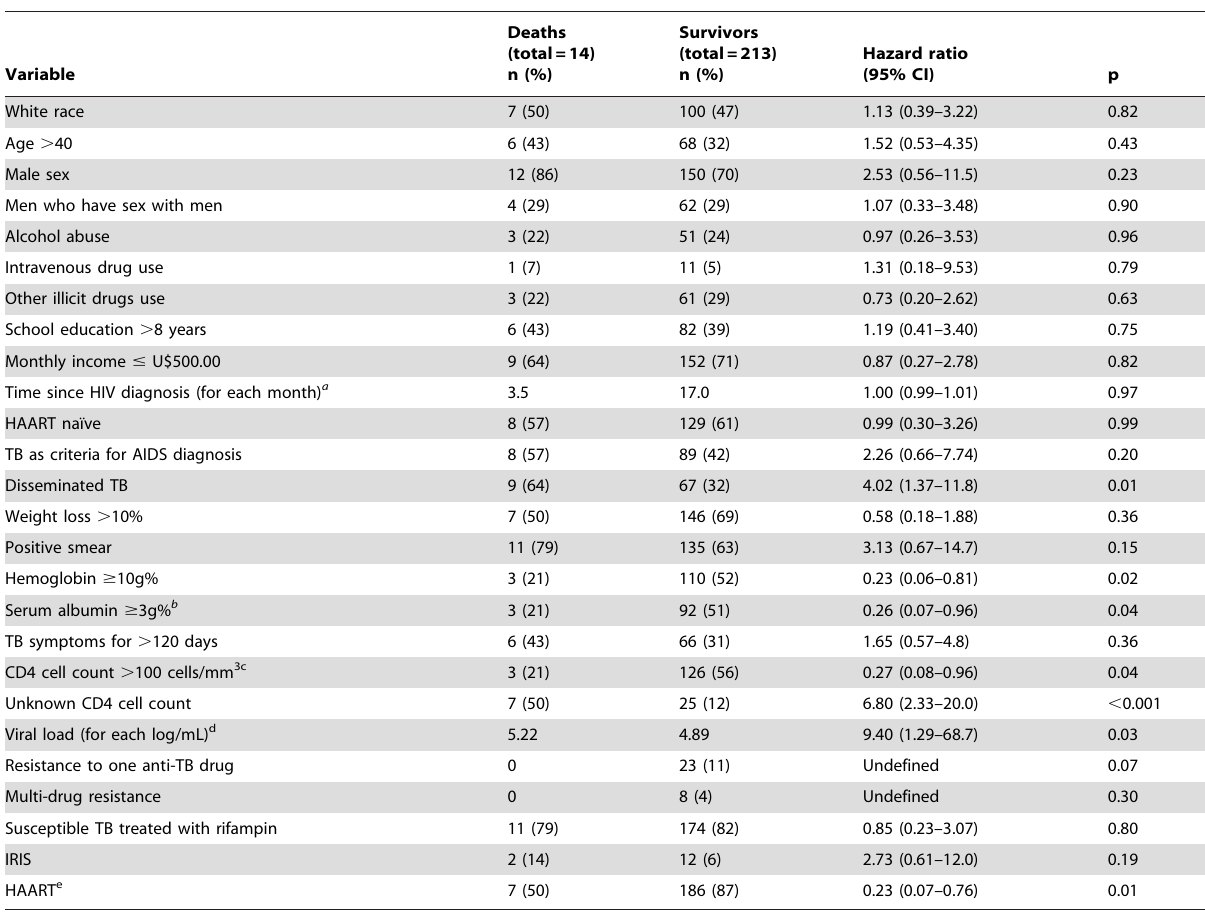
Table 2. Univariate Cox Analysis of Predictors of Early Mortality.